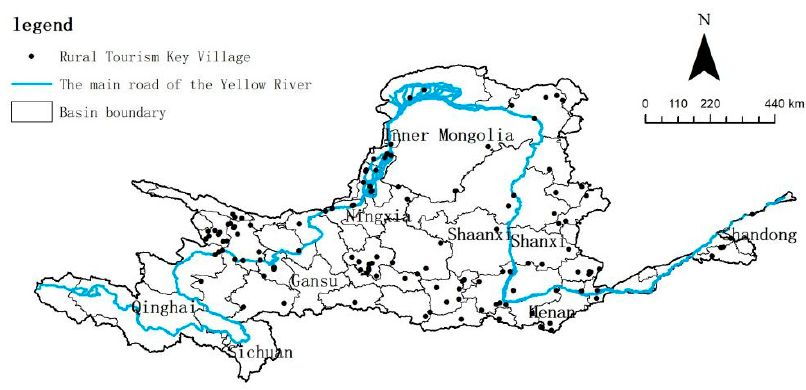
Figure 1. Distribution map of key rural tourism villages in the Yellow River